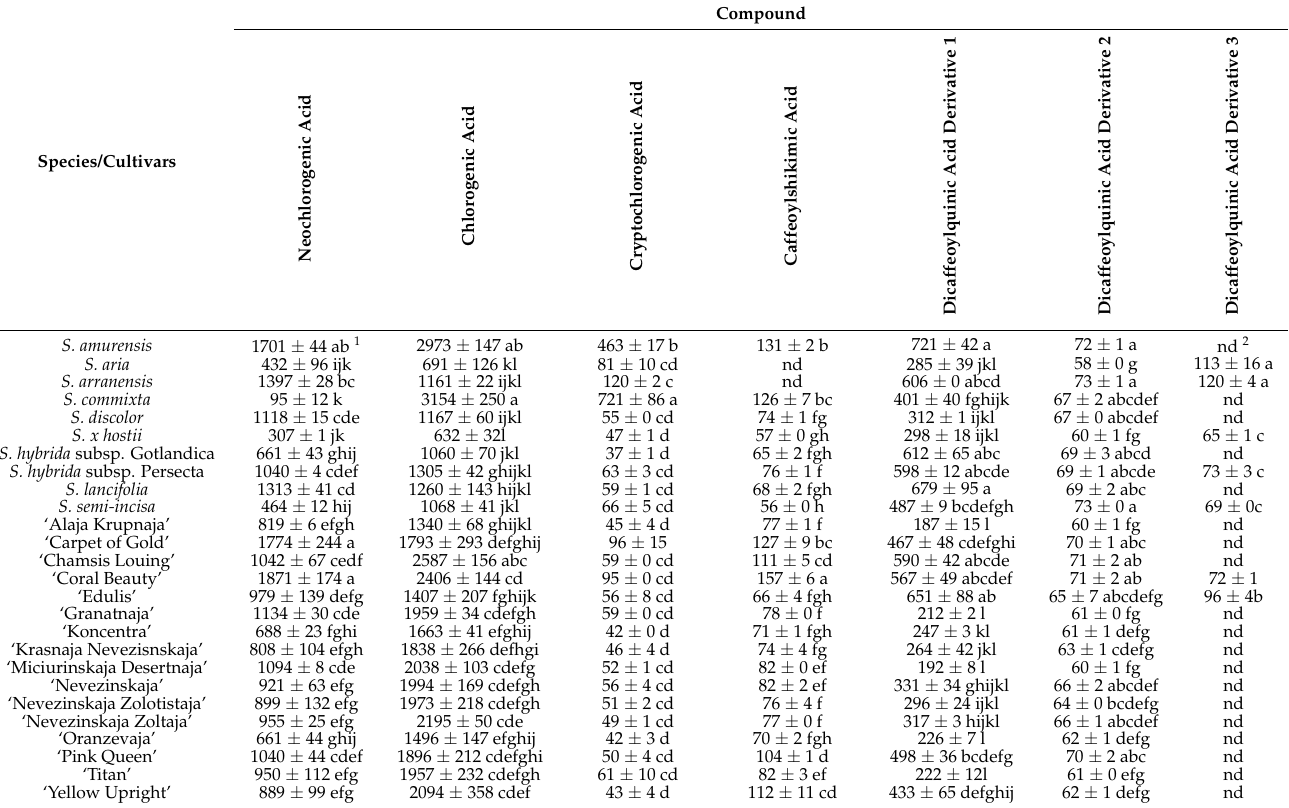
Table 1. Concentrations of phenolic acids ( µ g/g DW) in Sorbus